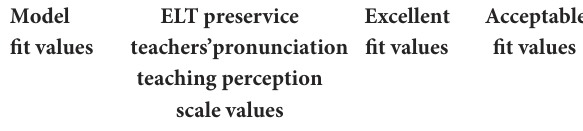
TABLE 3 Confirmatory factor analysis model fit